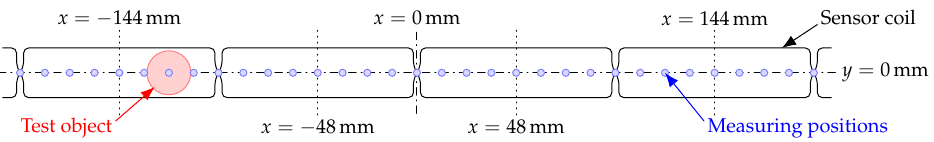
Figure 7. Schematic of the measurement positions (center of the coin) and the relative size of the sensor coil and test object 1 on a section of the sensor coil